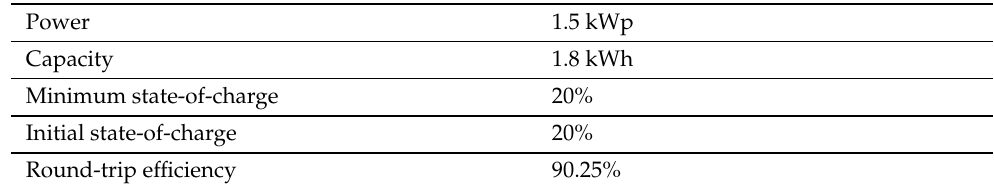
Table 1. Agents’ storage system configurations.